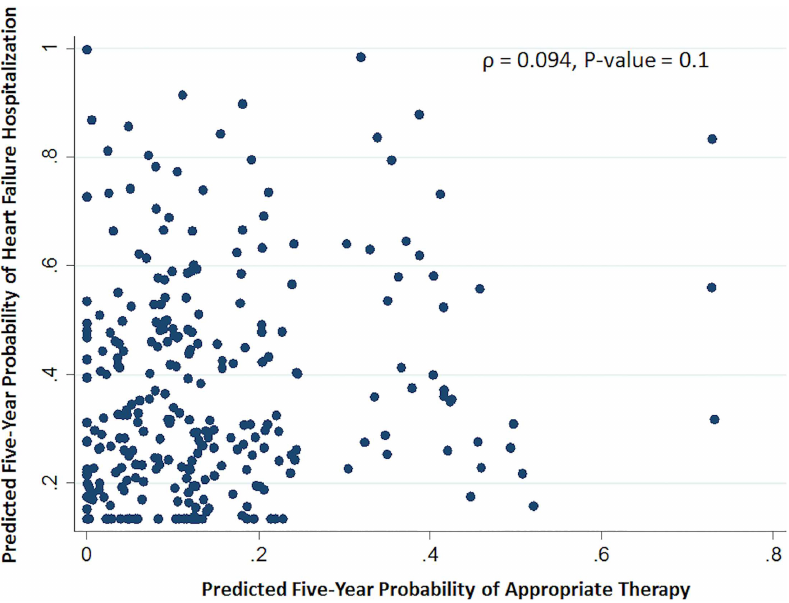
Fig 4. Scatter plot of five-yearprobability of HF hospitalization versus appropriate therapy.